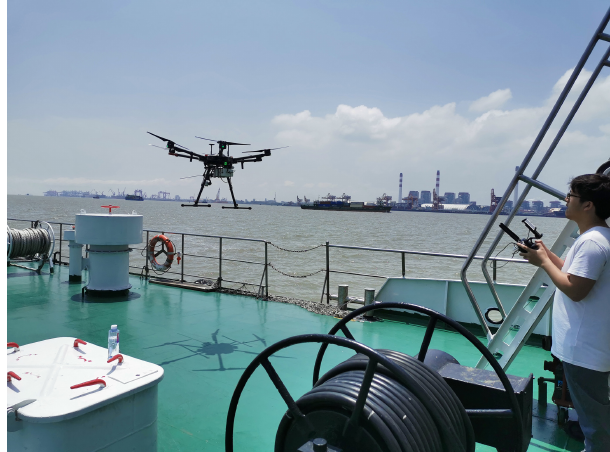
Figure 2. Monitoring regions in the channel of Yangtze River es- tuary, which belong to the Chinese domestic emission control ar- eas (DECAs). This area is to the north of Shanghai, on the south- west side of Changxing Island. The distance between the two sides is ∼ 6–7km. Ships leave the Yangtze River and sail into the East China Sea through this channel. Map data: © MapWorld (http: //www.tianditu.gov.cn, last access: 5 March 2020).